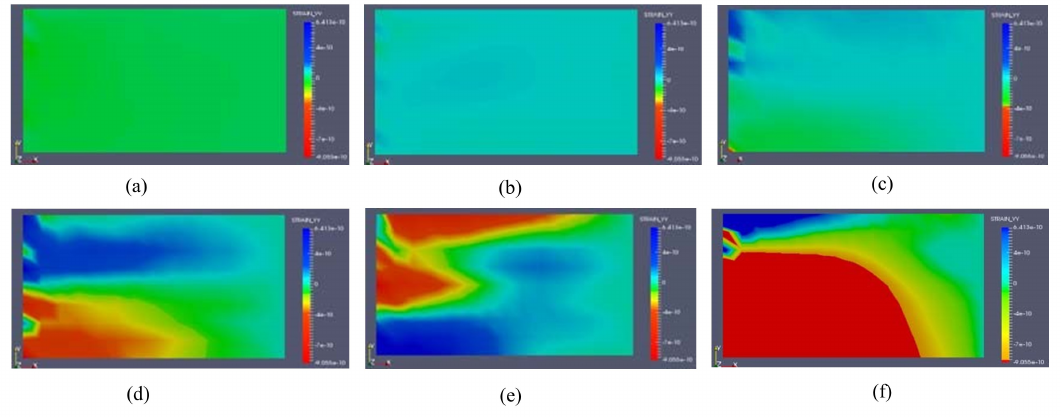
Figure 10. Vertical strain contour of SO-03 at ( a ) 0.5 MPa, ( b ) 2.5 MPa, ( c ) 10 MPa, and ( d ) 50 MPa in compression, and ( e ) 25 MPa and ( f ) 0.5 MPa in